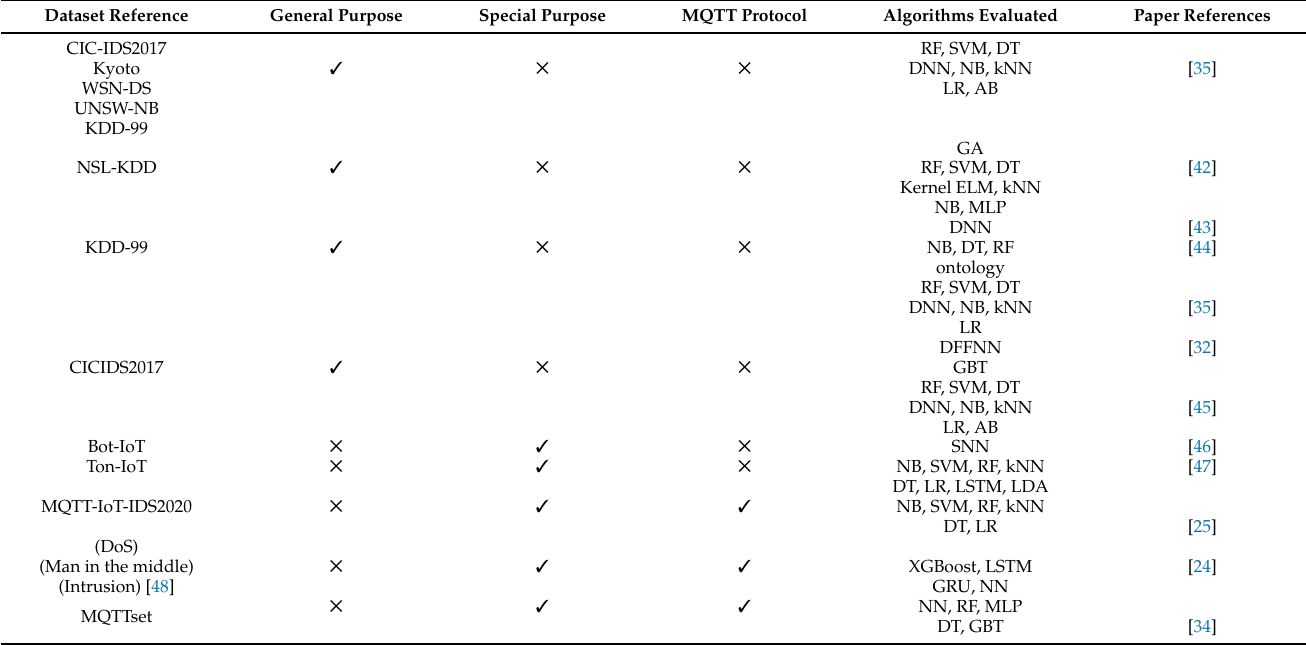
Table 3. Special and general purposed dataset for IDS